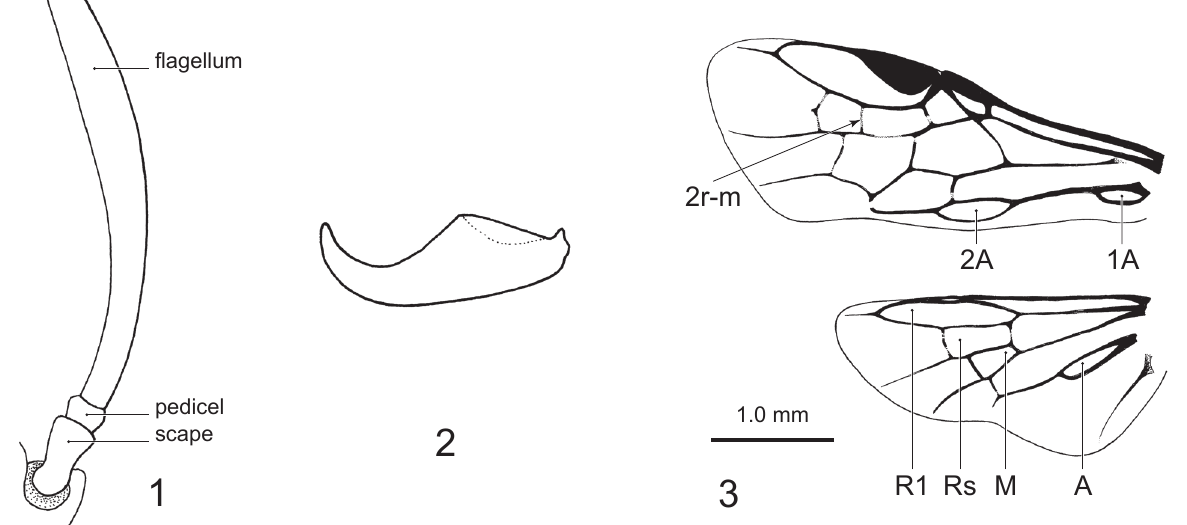
Figures 1–3. Pampsilota sp.: 1. Antenna; 2. tarsal claw; 3. Fore wing (above), hind wing (below). Host plants. Lannea nigritana (Anacardiaceae): only known for P. dahomeyanus